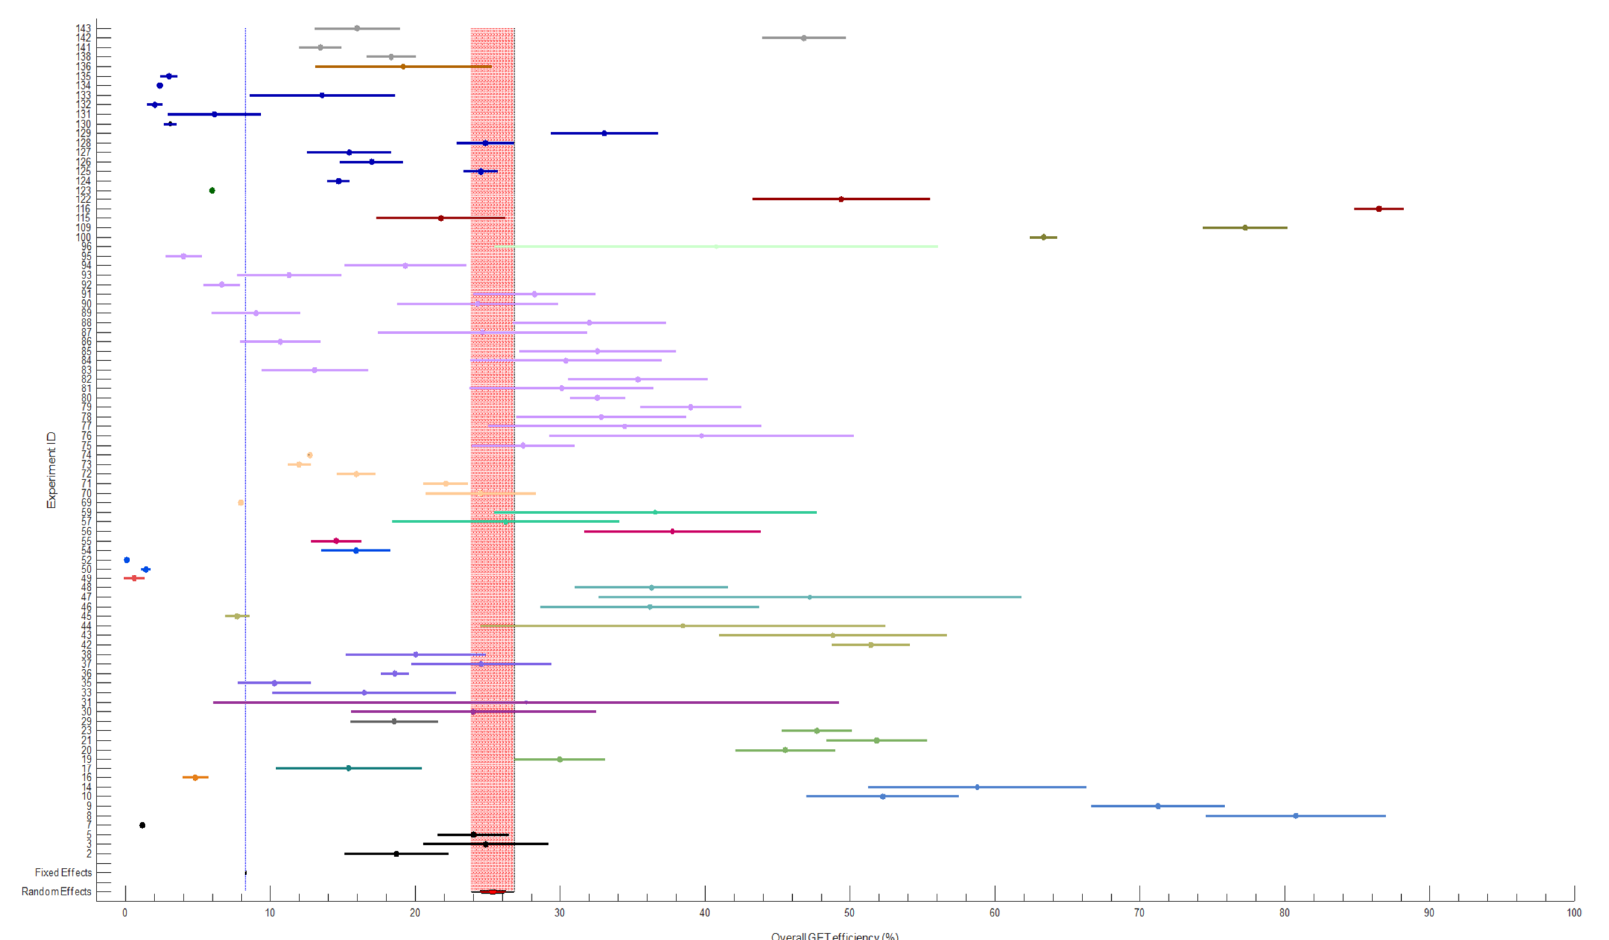
Figure 15. Forest plot showing the mean of each experiment (circle) with 95% CI (line) along with the estimate of the global overall GET efficiency (red band) using the random effect model. The size of the circle reflects the weight of the experiment in the pooling. The experiments reported in the same paper are colored with the same color. The experimental parameters of each experiment marked with experimental IDs can be found in Supplementary Table S1.